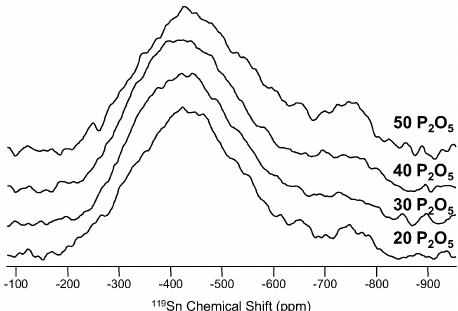
Figure 16. Wideline 119 Sn NMR spectra, measured at 11.7 T, for a series of tin fluorophosphate glasses ((60 − x)SnF 2 -40SnO-xP 2 O 5 ) with P 2 O 5 contents given to the right of each spectrum. The main feature around − 450 ppm is from Sn 2+ and is relatively unaffected by glass composition. A weak resonance around − 750 ppm, assigned to Sn 4+ , is detected in several glasses and is most intense at the highest P 2 O 5 content